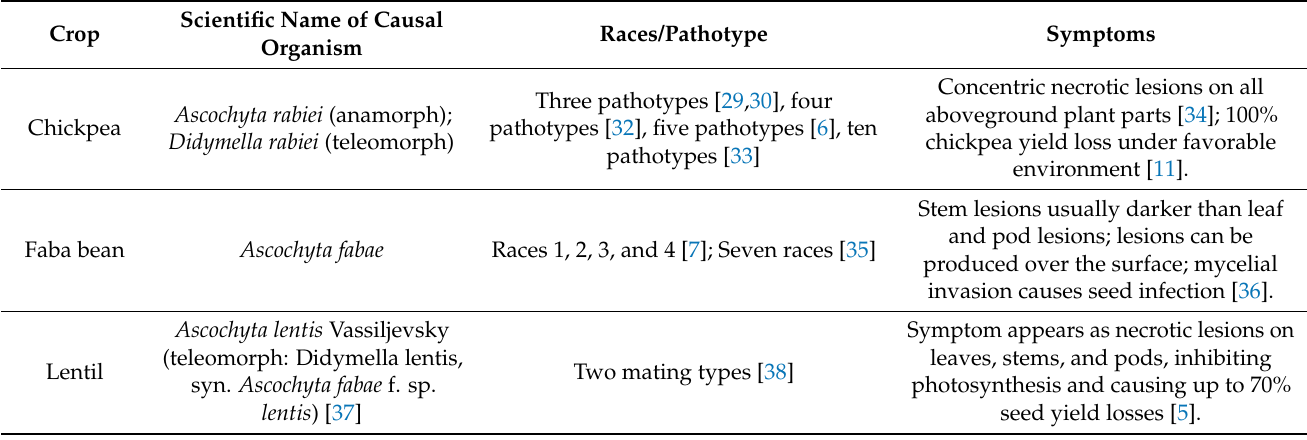
Table 1. Races/pathotypes of Ascochyta blight and its major symptoms in major grain